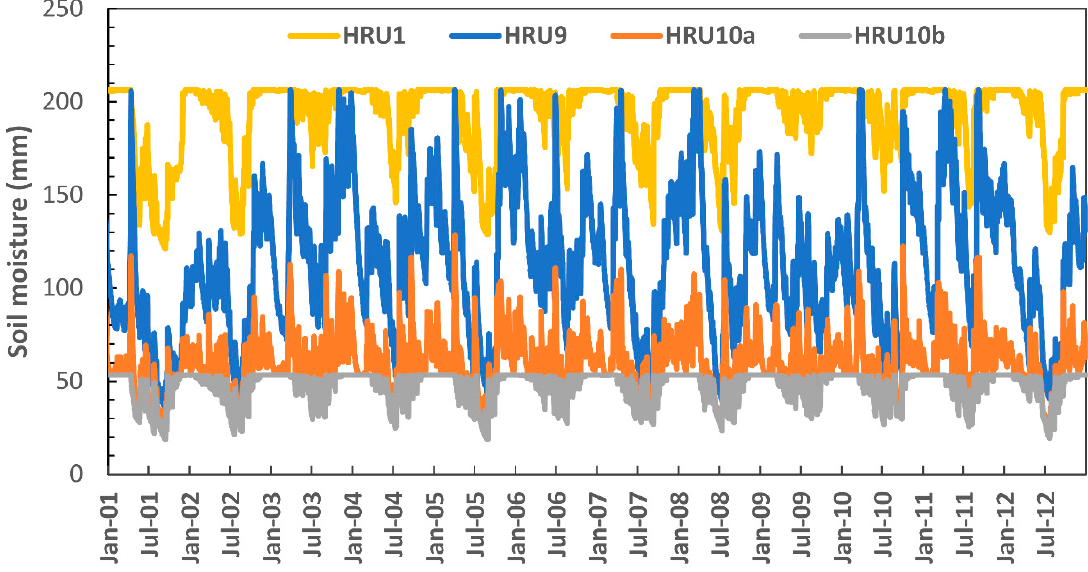
Figure 5. Simulated lateral flow by SWAT-wil and SWAT-HS for the Town Brook watershed. The lateral flows by SWAT-2012 are small and not shown.